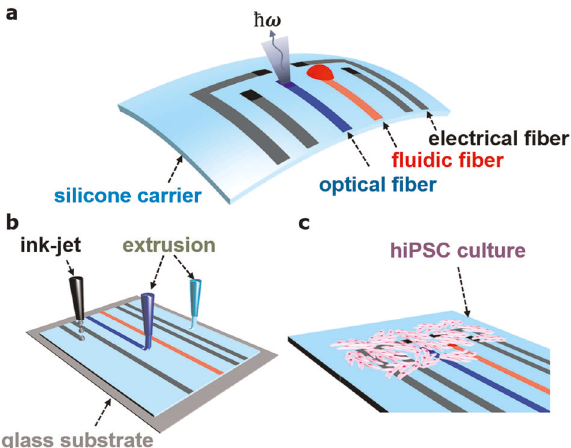
Fig. 1 Multimodal membranes for biointerfacing applications. a Concept for a sensor – actuator array with optical electrical and micro fl uidic functionality. b Fabrication is handled by micro- extrusion and ink-jet-based direct writing. c Multimodal membranes can be integrated with cell monolayers for lab-on-chip